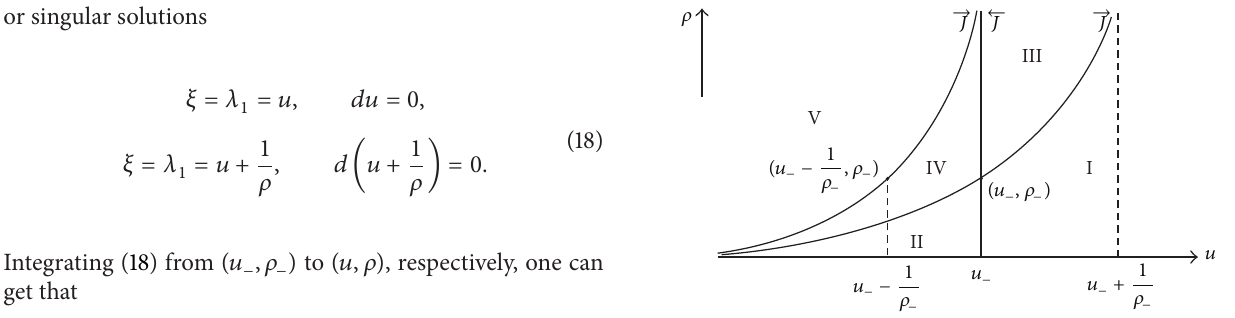
Figure 1: Contact discontinuity